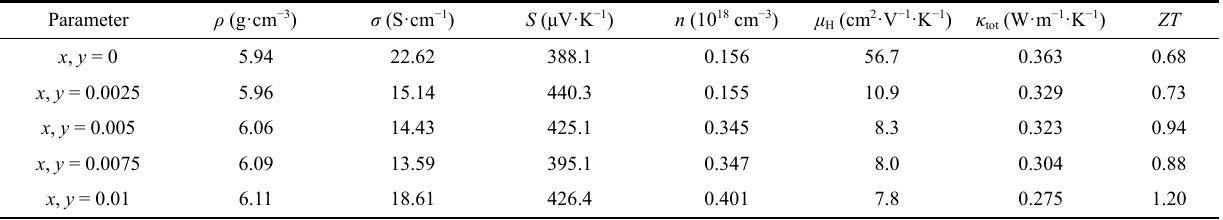
Table 2 Electrical and thermal transport of pure and doped SnSe sample: ρ , σ , S , n (585 K), μ H (585 K), κ tot , and ZT of x , y = 0, 0.0025, 0.005, 0.0075, and 0.01 at 785 K